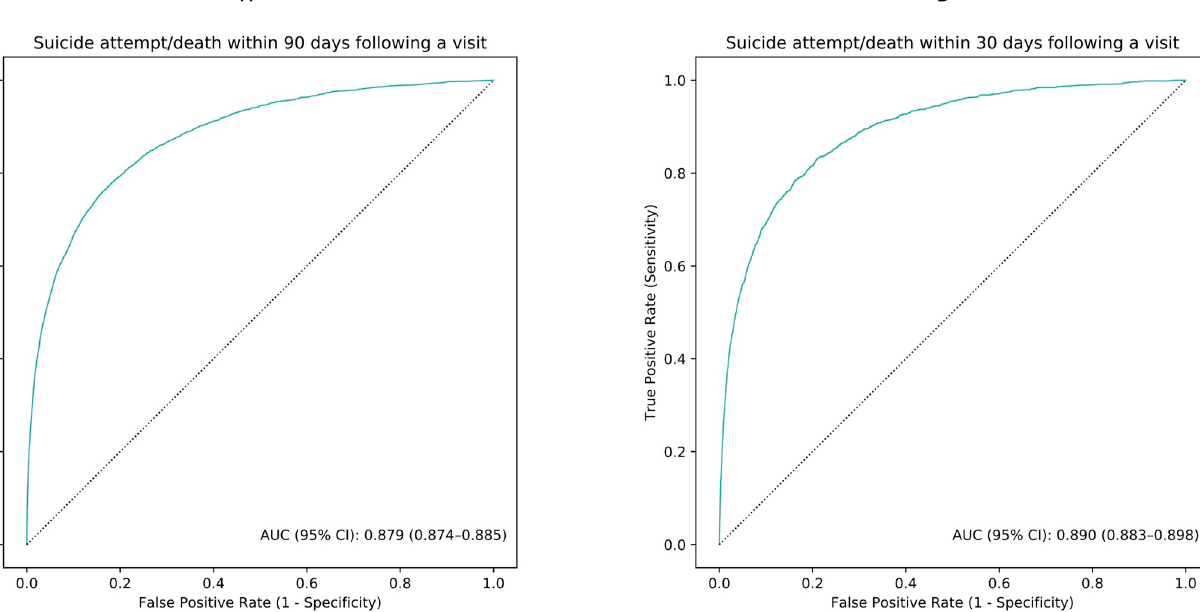
PLOS Medicine| https://doi.org/10.1371/journal.pmed.1003416 November6,